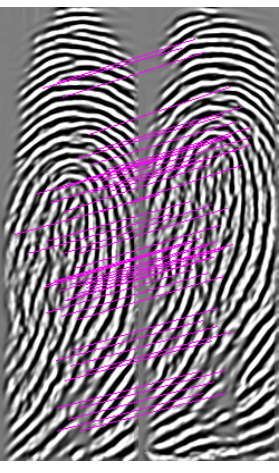
Figure 10. Example of genuine pairs in